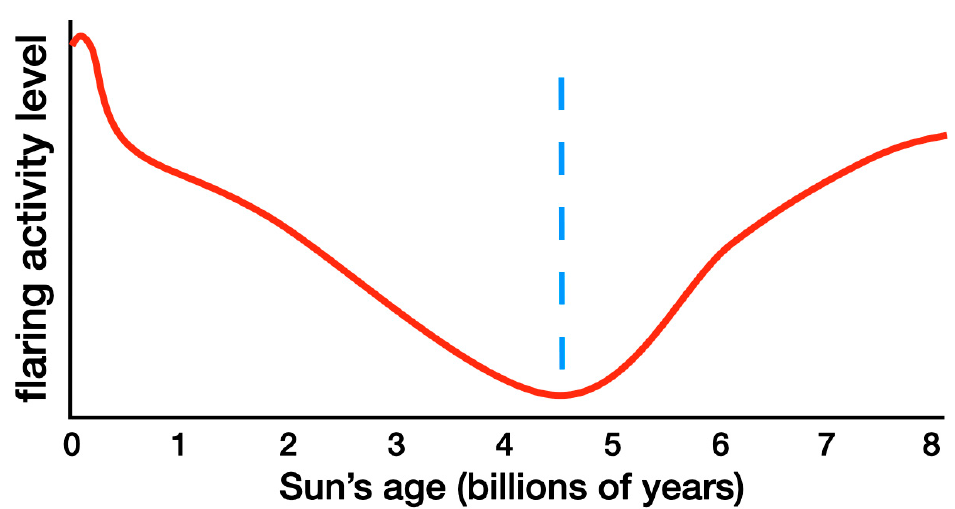
Figure 2. Sun’s Flaring Activity and X-ray Radiation Levels Throughout Its History (Maehara et al. 2012, 2015; Notsu et al. 2013, 2019; Shibayama et al. 2013; Metcalfe 2018; Reinhold et al. 2020; Zhang et al. 2020). The y -axis is logarithmic. The dotted line indicates the present. During its first half-billion years, the Sun’s flaring activity levels were more than 10,000 times greater than its present level. The Sun’s intensity of particle radiation, gamma-ray, X-ray, and ultraviolet emission strongly correlates with its flaring activity level. Only for stars that are virtually identical to the Sun and about 4.57 billion years old is global high-technology civilization possible on one of its planets. Diagram credit: Hugh Ross.